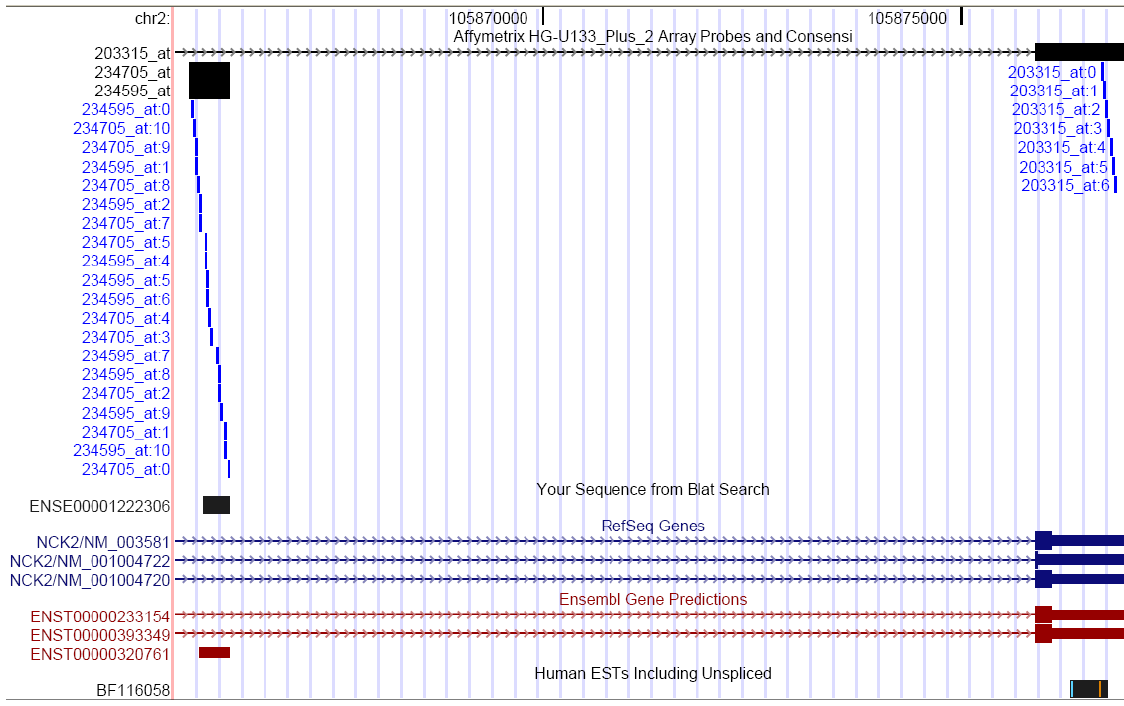
Figure S5. UCSC screen shot for